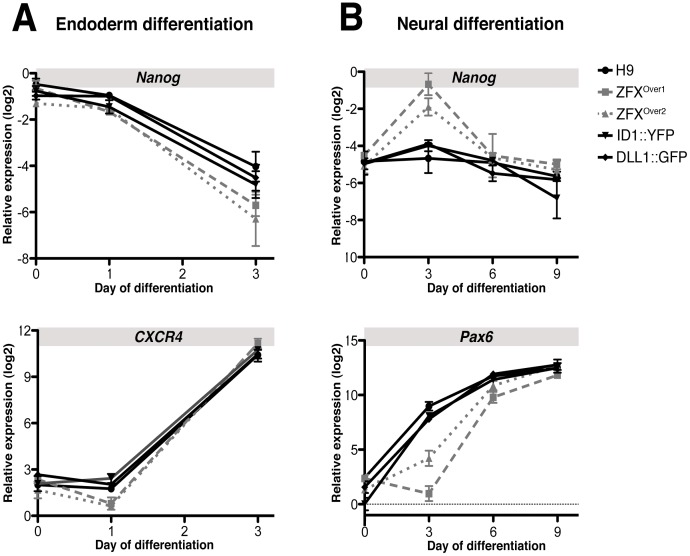
Directed differentiation of ZFXOver clones to endoderm and neural tissue.ZFXOver clones, two control clones that express normal ZFX levels (ID1::YFPc2, Dll1::GFPc277) and H9 were directed to endoderm or neural cells, and the level of Nanog, Pax6 (neural) and CXCR4 (endoderm) mRNA at each time point was measured by quantitative PCR.